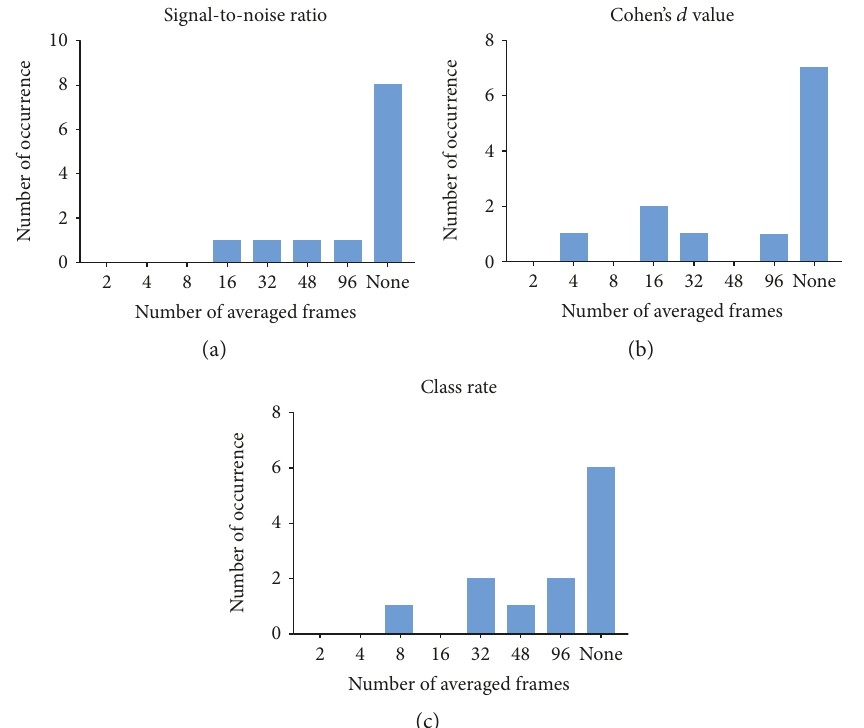
Figure 4: Intraindividual evaluation of quantitative measures of image quality for all 13 patients. On the x -axis, the number of averaged frames preoperatively is shown, which is needed to achieve the same result as an average of 16 frames postoperatively. A 16-frame scan provides the most bene fi cial setting after cataract surgery. Comparison is computed individually for each patient. On the y -axis, the number of cases is shown. “ None ” indicates that there was no averaging setting preoperatively, which achieved the same result as